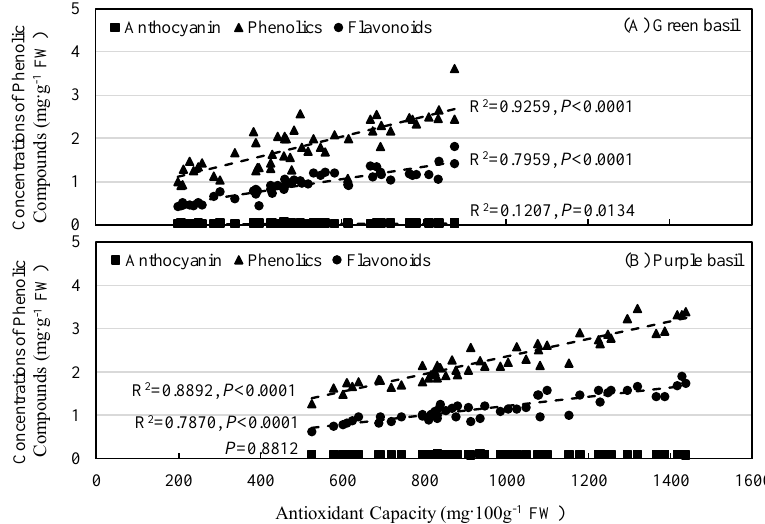
Figure 6. Correlation between antioxidant capacity and concentrations of anthocyanin, phenolics, and flavonoids in green basil plants ( A ), and purple basil plants ( B ). Dashed lines show the regression between concentrations of phenolic compounds with antioxidant capacity according to Pairwise Correlation method.